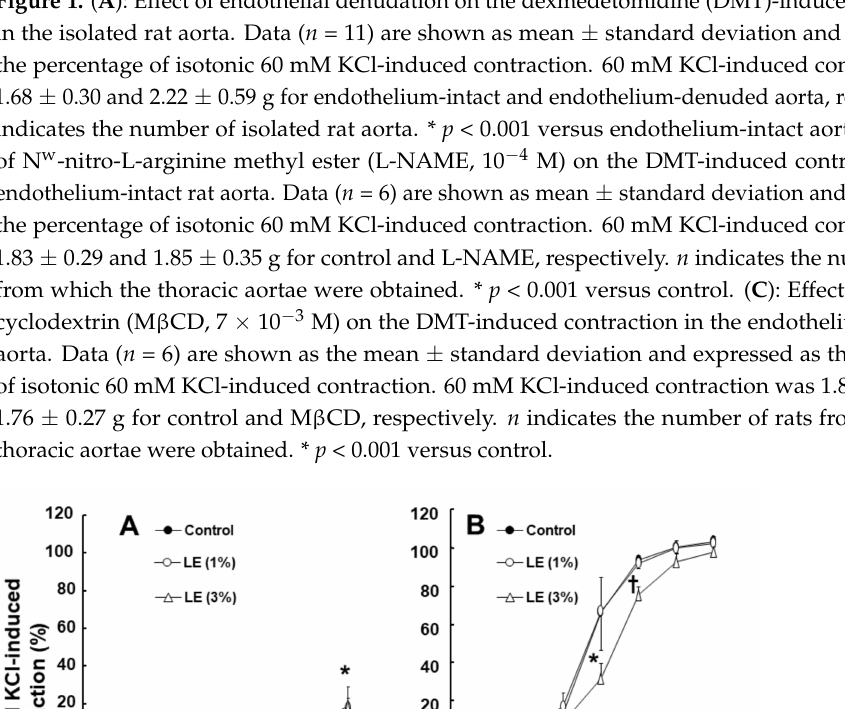
Figure 2. Effect of lipid emulsion (LE) on the dexmedetomidine (DMT)-induced contraction in the endothelium-intact ( A , n = 6) and endothelium-denuded ( B , n = 5) rat aortae. Data are shown as mean ± standard deviation and expressed as the percentage of isotonic 60 mM KCl-induced contraction. n indicates the number of rats from which the thoracic aortae were obtained. † p < 0.01 and * p < 0.001 versus control. ( A ): 60 mM KCl-induced contraction was 1.92 ± 0.04, 1.95 ± 0.14, and 1.97 ± 0.39 g for control, 1 and 3% LE, respectively. ( B ): 60 mM KCl-induced contraction was 1.77 ± 0.22, 2.02 ± 0.18, and 1.96 ± 0.12 g for control, 1 and 3% LE,